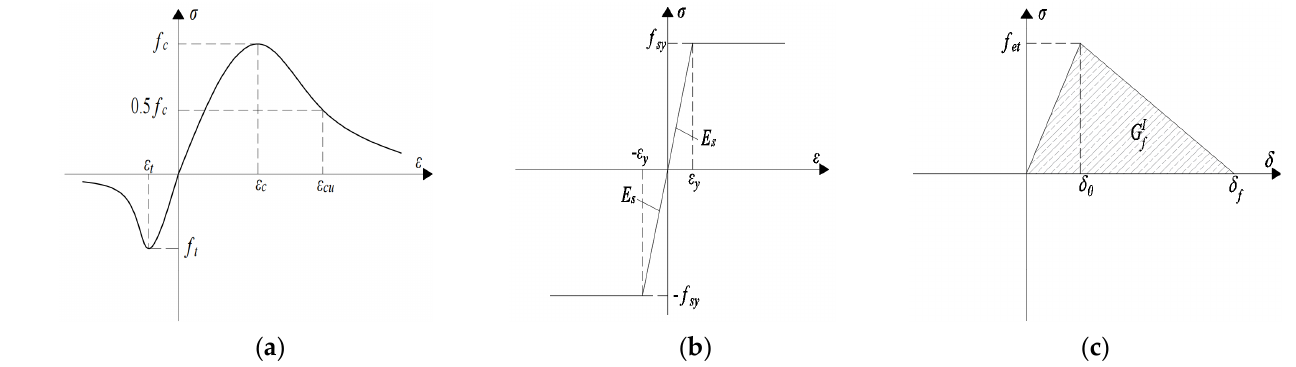
Figure 12. Material constitutive relationship. ( a ) NC. ( b ) Steel. ( c ) Cohesive.